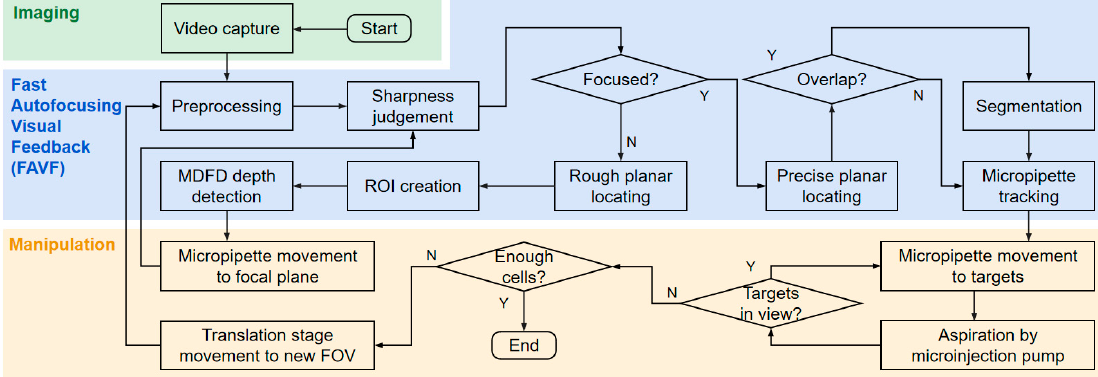
Figure 8. Overall process of automated cell sorting.